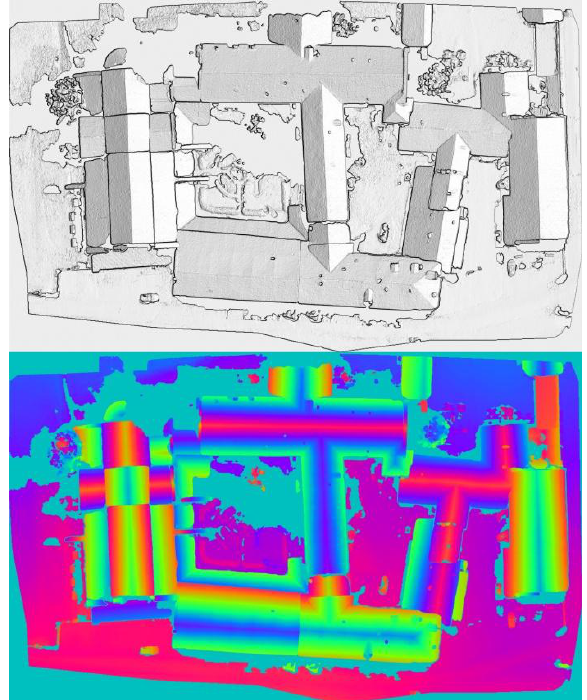
Figure 13. DSM extracted using MicMac: shaded view (above), 8bit colour view (below)